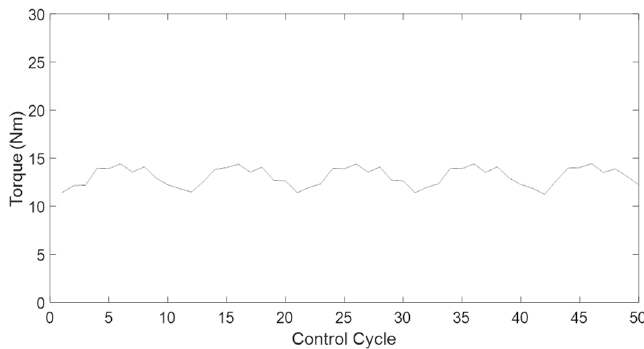
Figure 16. Influence of the third torque variation on torque output on cSVM-DTC2.